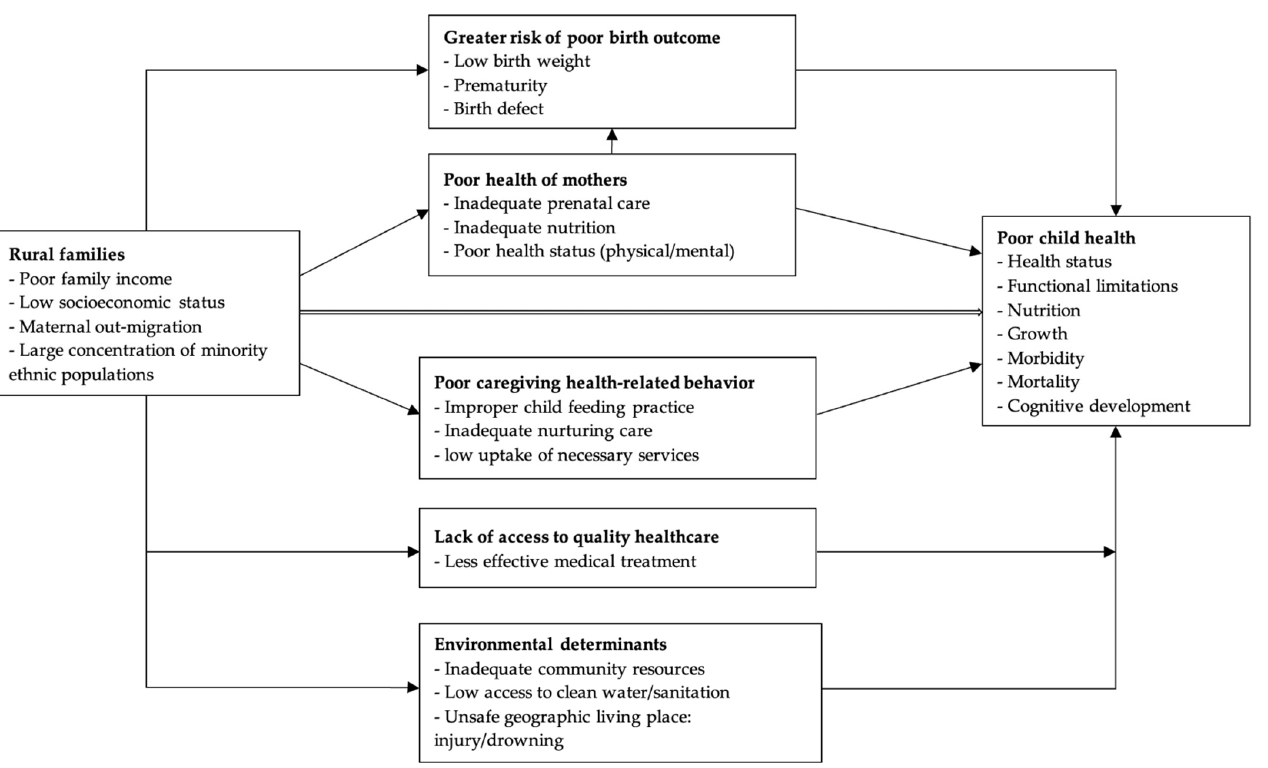
Figure 1. Review of major factors explaining the health gaps of rural children in China.